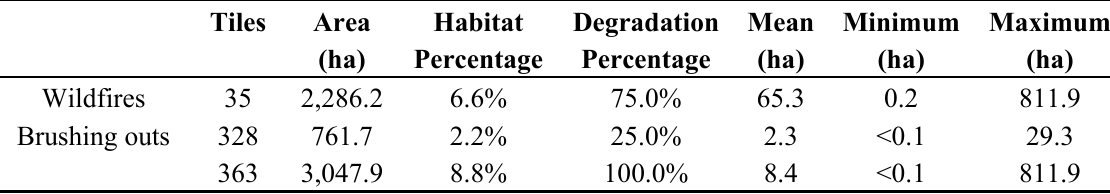
Table 3. Stats of the different causes for the degradation of dry heaths in the SCI Os Ancares–O Courel during the period